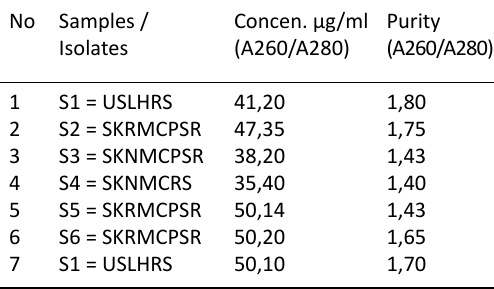
Table 6. Concentration and purity of the extracted DNA